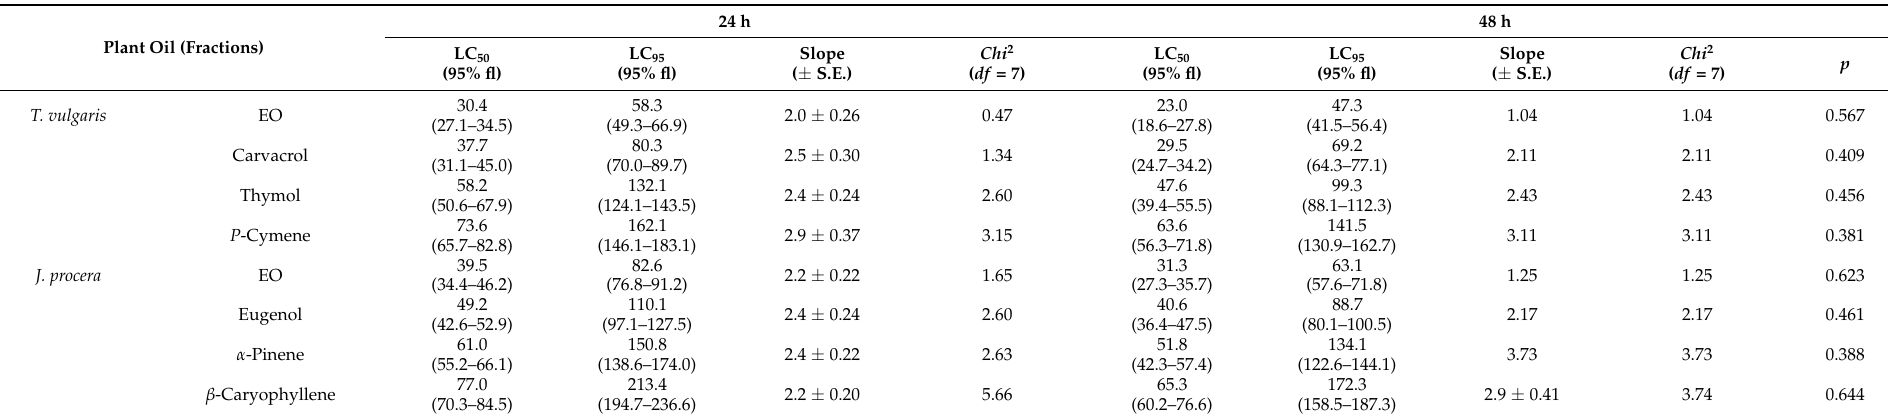
Table 4. Fumigant larvicidal activity ( µ L/L) of the tested plant oils and their major terpenes against T. granarium .